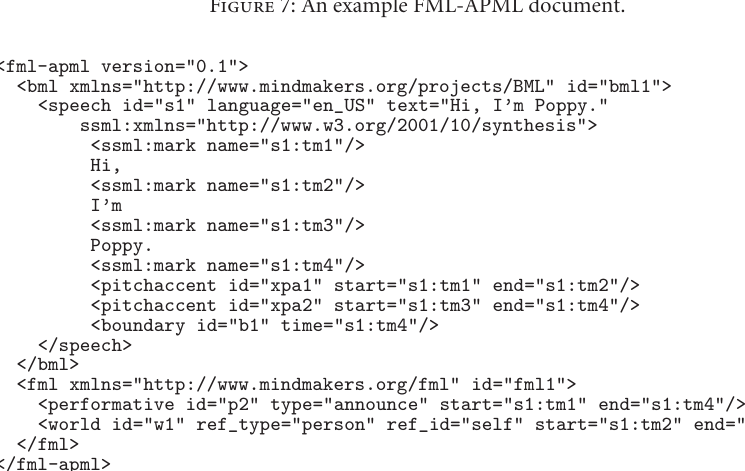
Figure 7: An example FML-APML document.